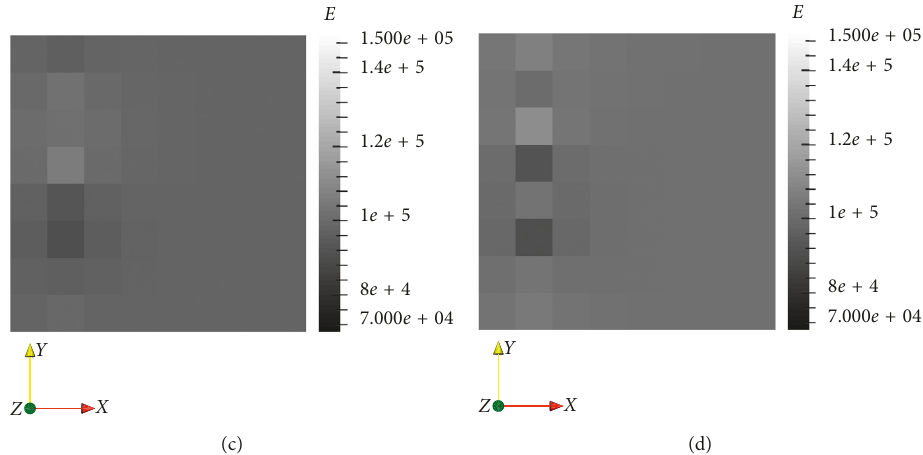
Figure 3: Example realisation j for unconditional field (a), conditional field (b), kriged field based on random field values at measurement locations (c), and kriged field based on measurement values (d), 1 CPT.